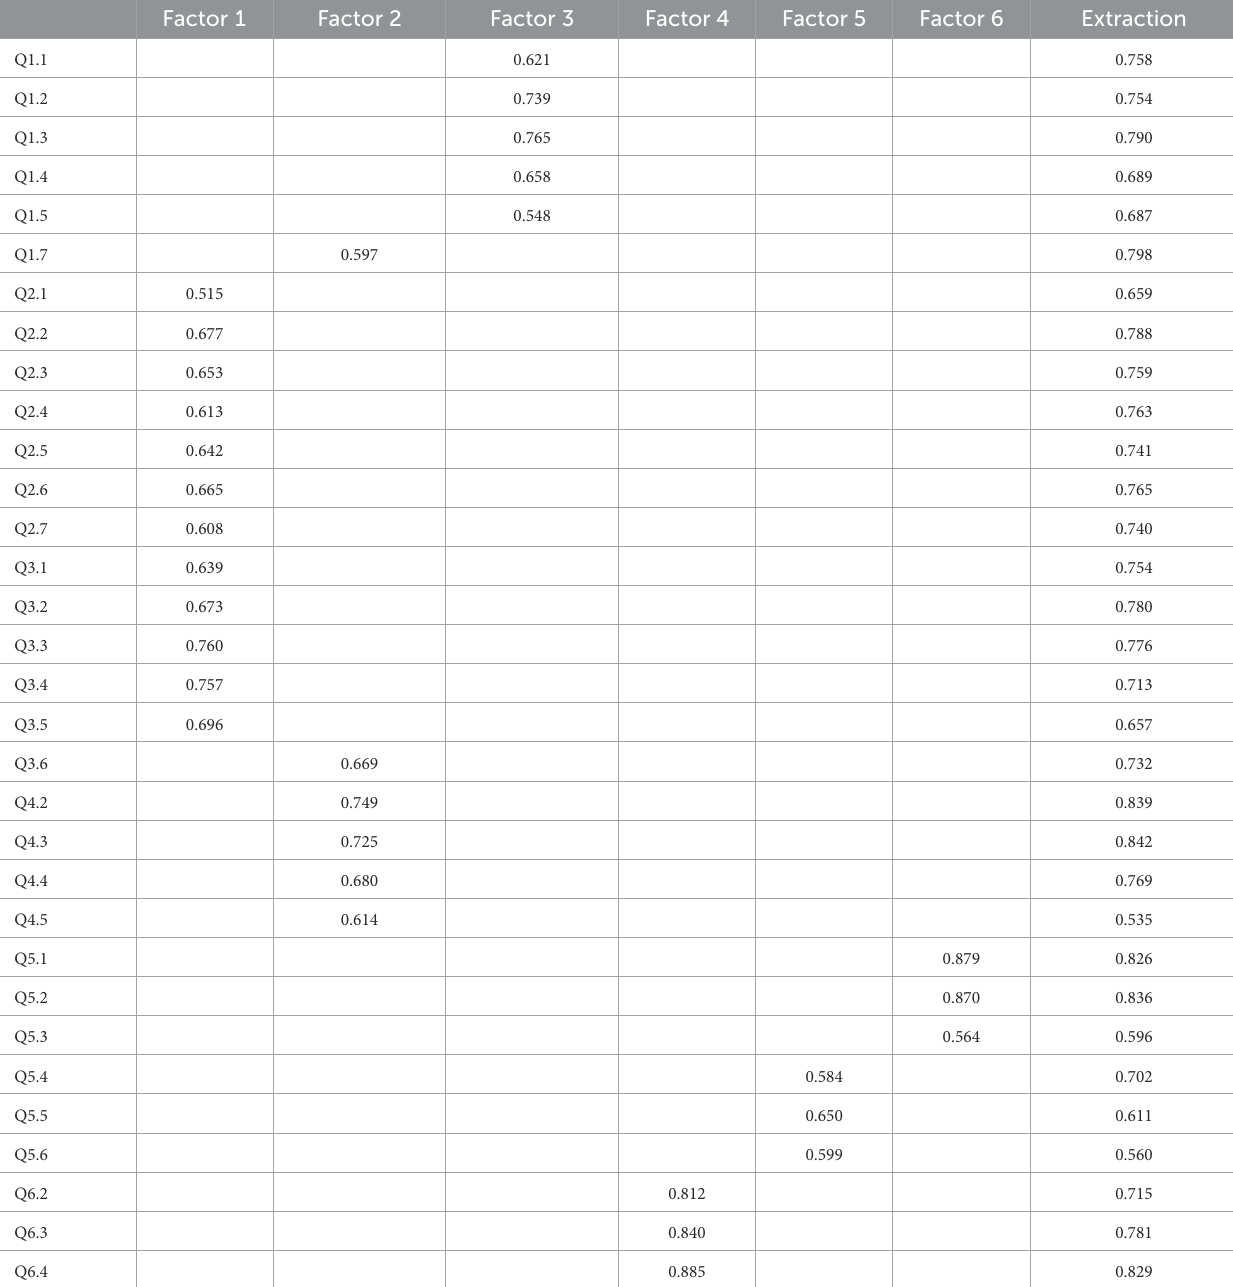
TABLE 3 Each factor rotated component